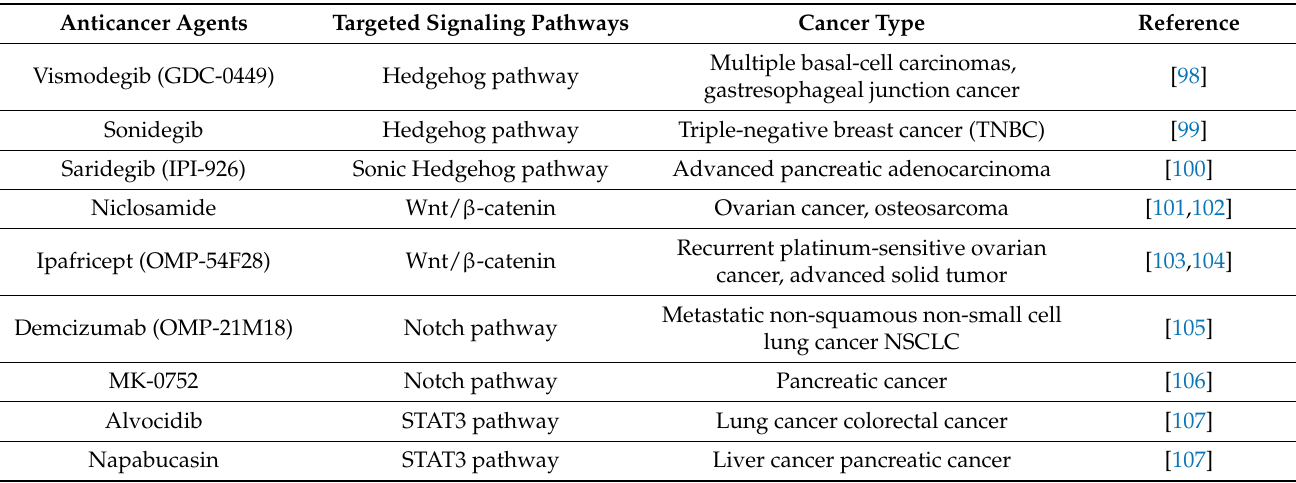
Table 4. Other anticancer agents targeting CSCs signaling